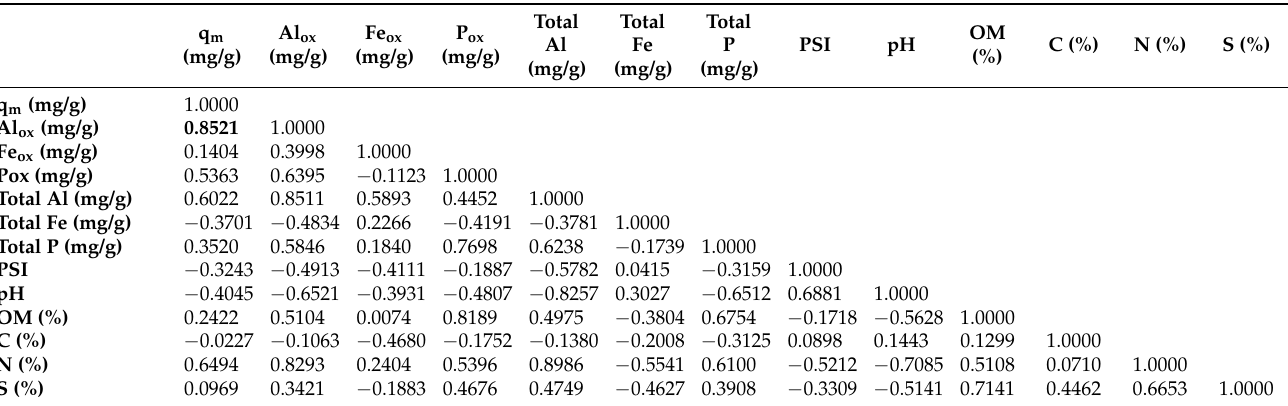
Table 3. Correlation matrix.